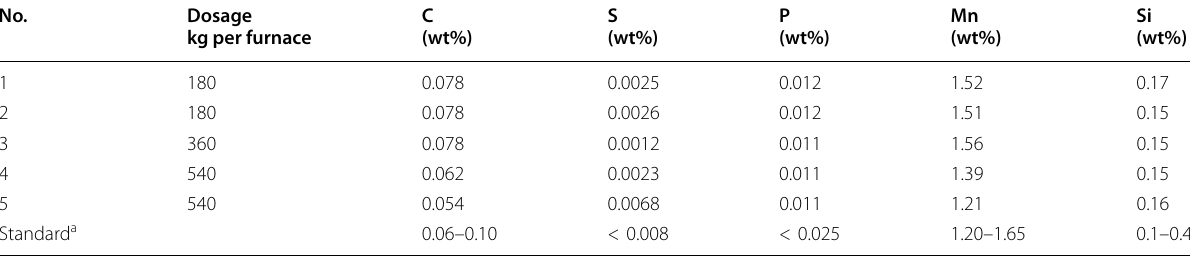
Table 1 Chemical components of hot metal in co-disposal process